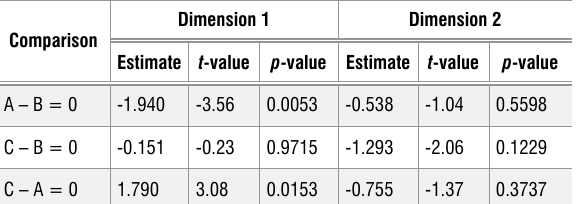
Post-hoc pairwise comparisons (Tukey contrasts) showing the estimated difference (linear contrast) between the three groups of land managers along the first and second dimensions of the constrained principal component analysis (Figure 2b). The null hypothesis tested is that there is no difference between group- scores; p -values were adjusted for multiple testing using a single-step method based on the t -distribution.